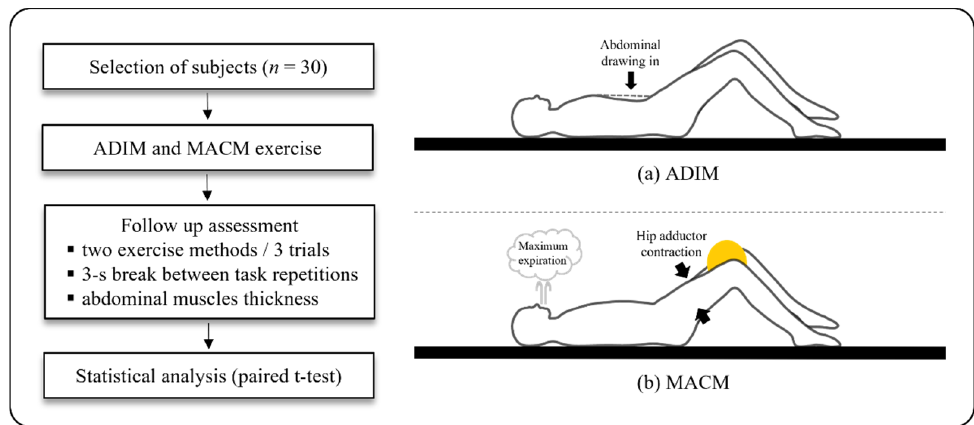
Figure 1. Flowchart of the experimental protocol and the two maneuvers. ( a ) ADIM: abdominal draw-in maneuver and ( b ) MACM: maximum abdominal contraction maneuver.